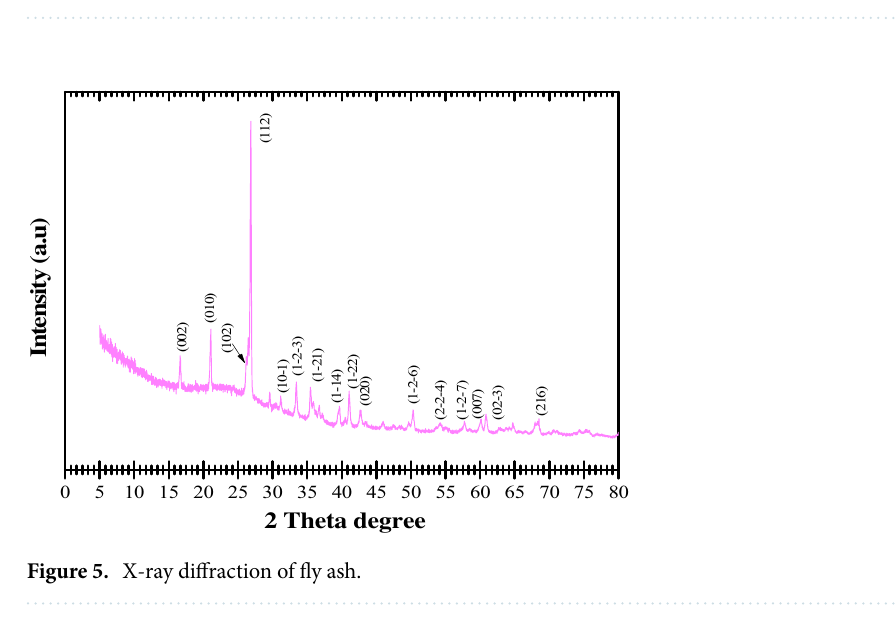
Table 1. Functional groups assigned to wavenumbers.